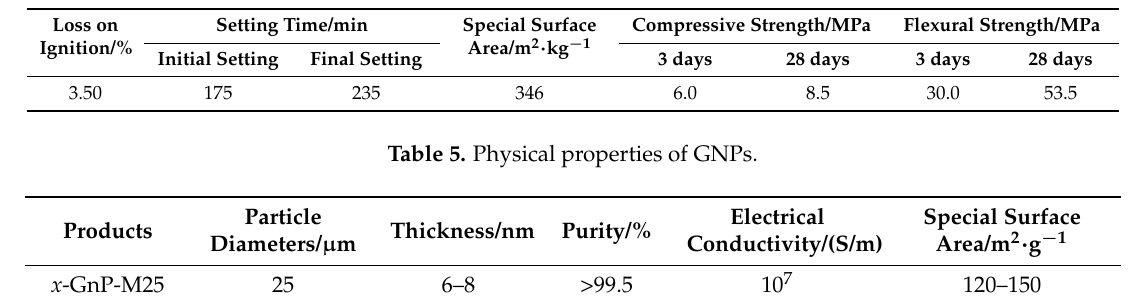
Table 4. Physical parameters of the cement.